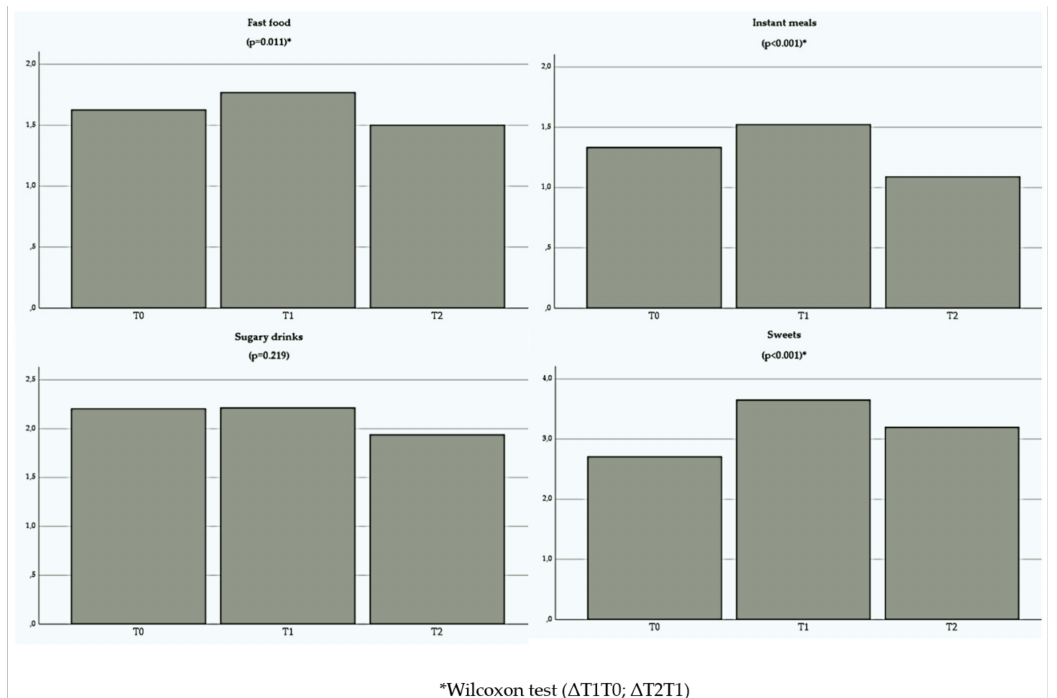
Figure 6. Frequency of Food Consumption reported by volunteers in the first and second phases of the